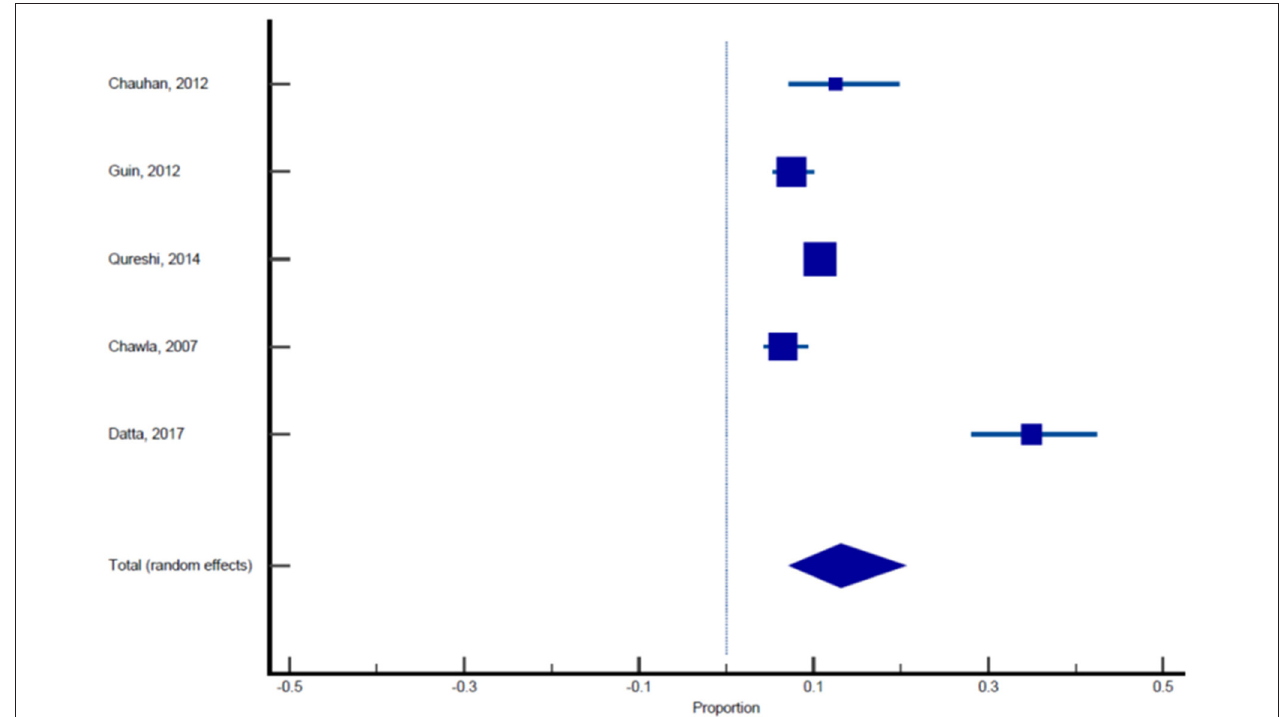
FIGURE 5 | Forest plot showing prevalence of malaria in symptomatic pregnant females, the blue diamond indicates the pooled prevalence and the horizontal line shows the 95% confidence interval.